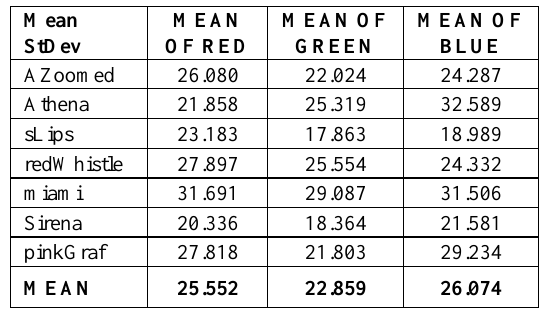
Table 3: Mean of Standard Deviations in Red, Green, Blue of the 6 De-mosaicking algorithms for every dataset.